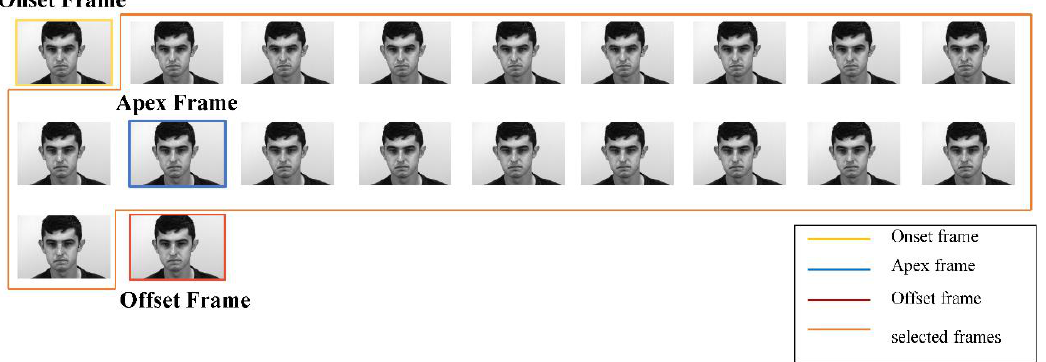
Figure 3. Frame selection with 9 frames before the apex frame and 8 frames after the apex frame.